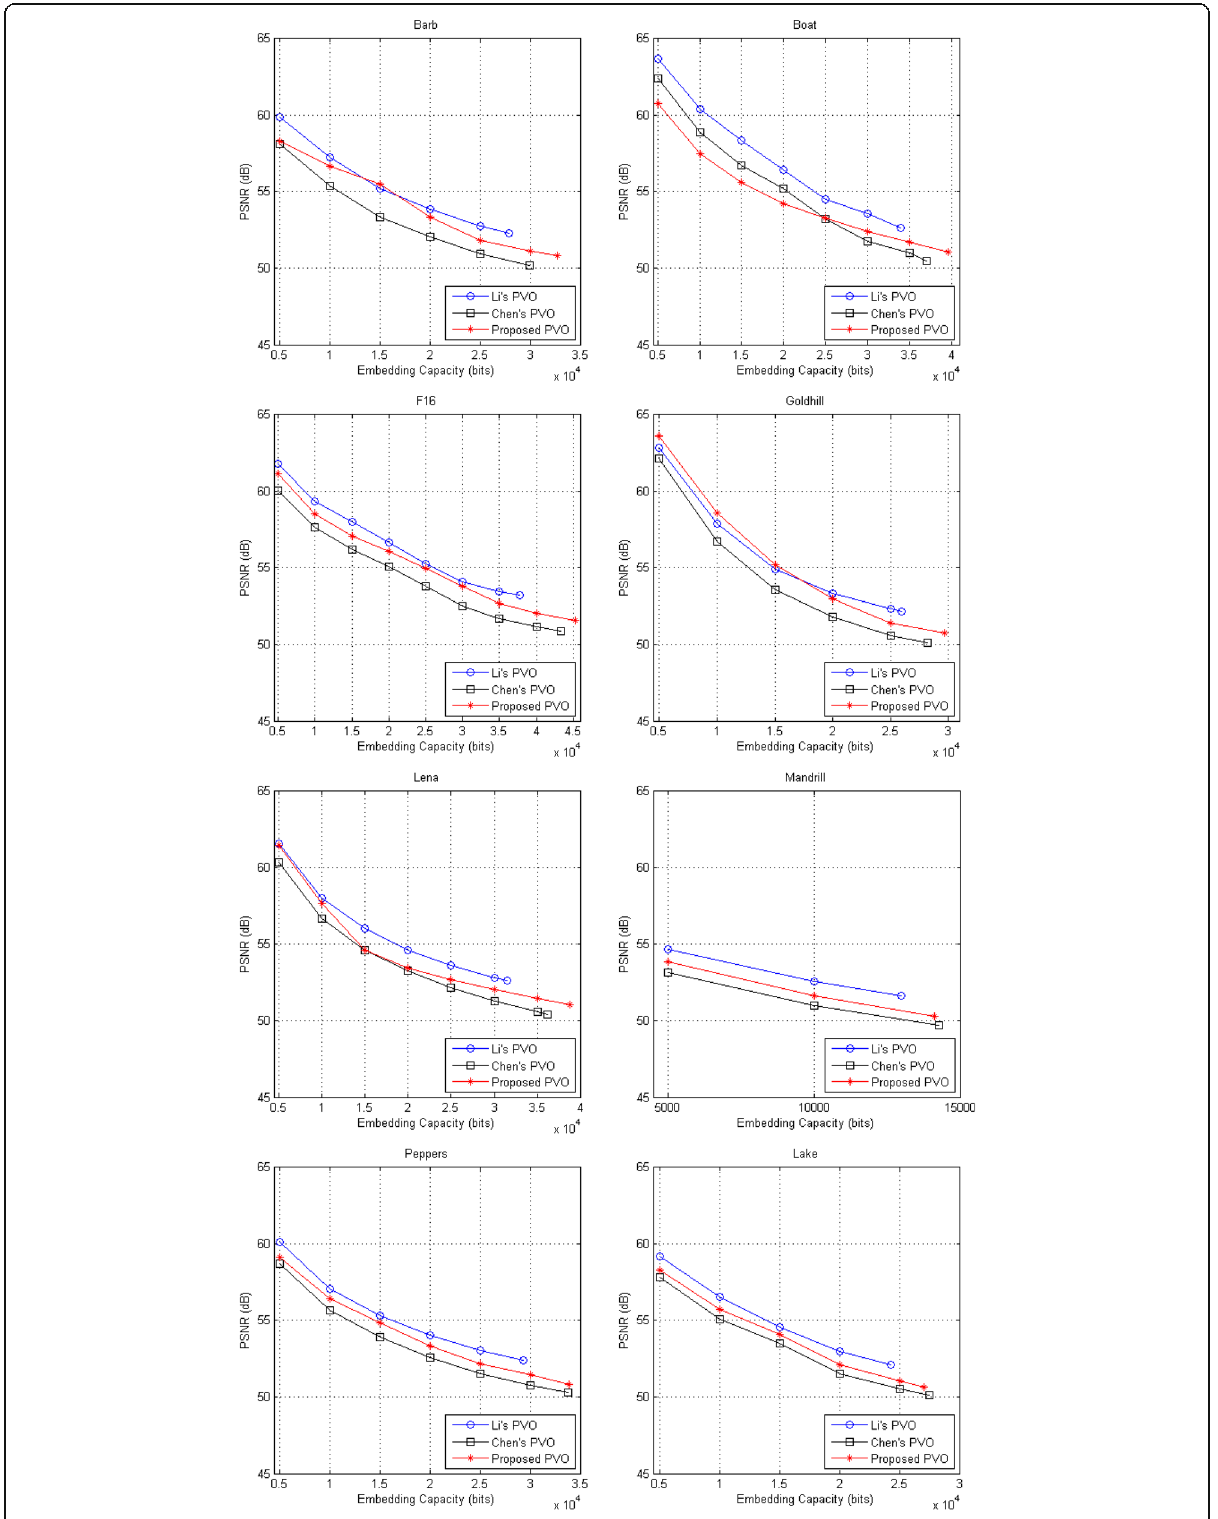
Fig. 10 Rate-distortion curves of embedding bits using the proposed PVO with respect to test image quality, including Barb, Boat, F16, Goldhill, Lena, Mandrill, Peppers, and